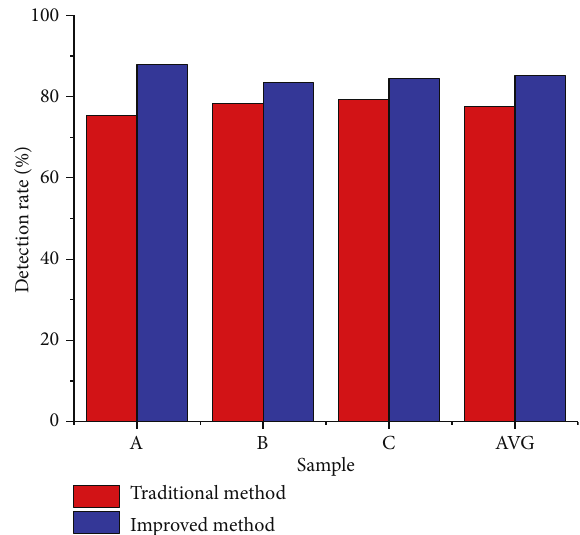
Figure 3: Comparison of detection rate before and after improvement.